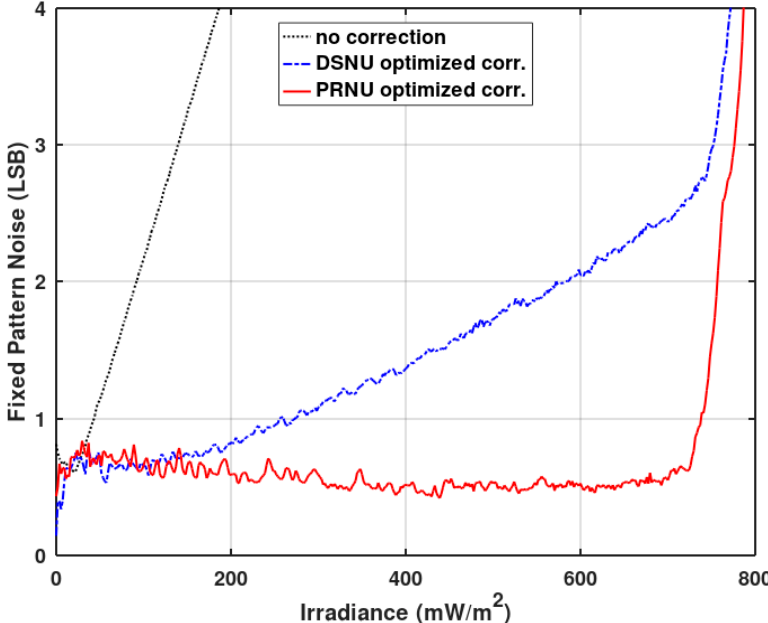
Figure 10. Measured fixed pattern noise (FPN) of the presented imager as a function of the irradiance without corrections, with the offset and gain correction (offset correction takes precedence), and with the offset and gain correction (gain correction takes precedence).